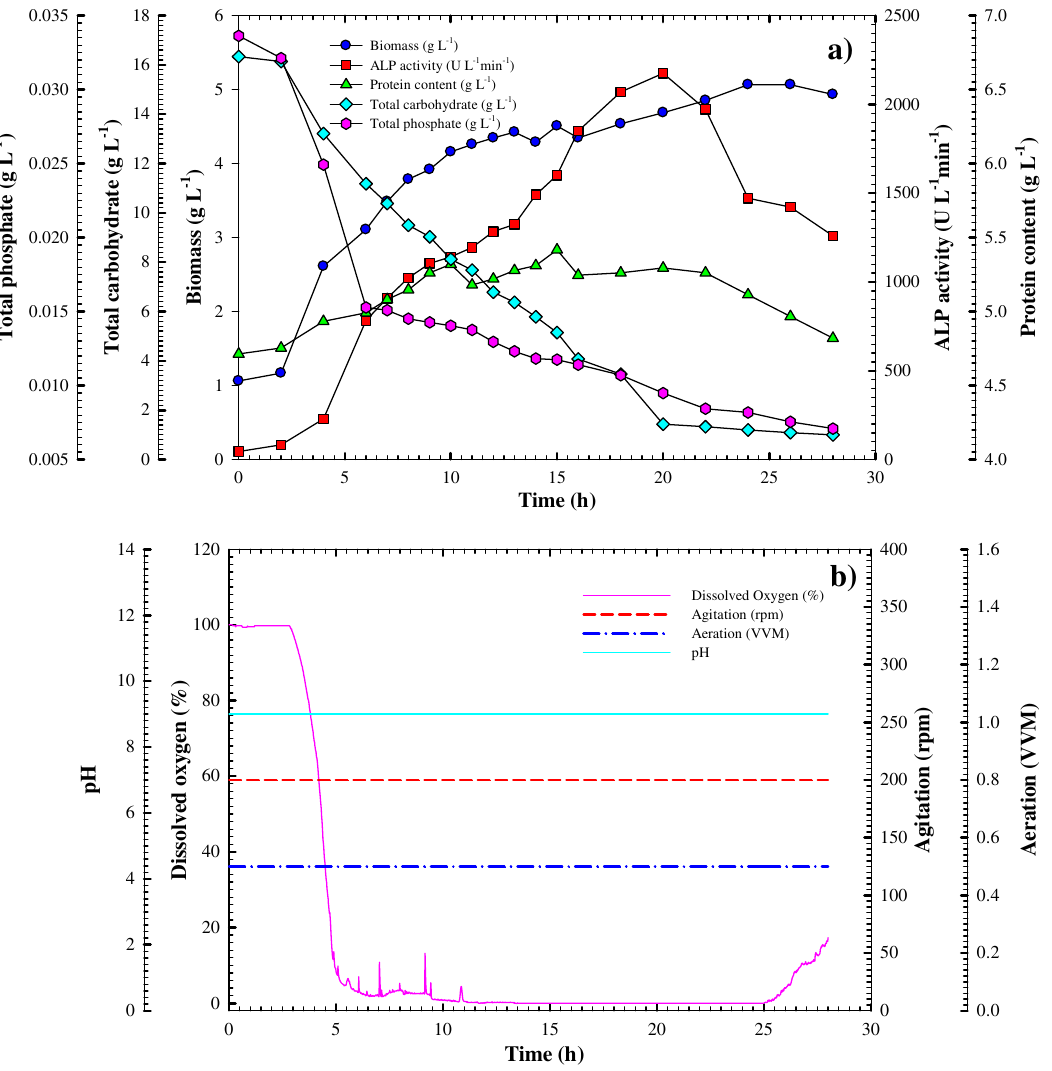
Figure 7. ( a ) Growth and ALP productivity monitoring of Bacillus paralicheniformis strain APSO in a 7 L stirred tank bioreactor under a controlled pH. ( b ) On-line data (dissolved oxygen, agitation, airflow rate, and pH) as a function of time during said batch